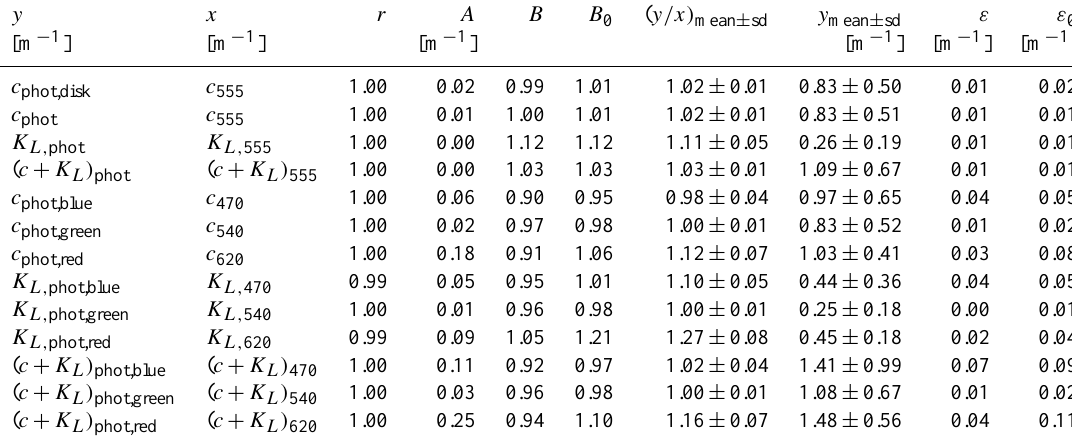
Table 5. Linear relationships of the forms y = A + Bx and y = B 0 x obtained by correlation analysis of attenuation coefficients of spectrally integrated luminance for the open eye and with blue, green and red glass filters and coefficients of monochromatic radiance at 470, 540, 555 and 620nm, and mean values of y/x and y . The attenuation coefficients are averages over the depth range 0– Z D,white . r is the correlation coefficient. The error ε is the root mean square of the deviations ( y – A – Bx ), and ε 0 is the rms of ( y − B 0 x) . The analysis is based on 32 stations.